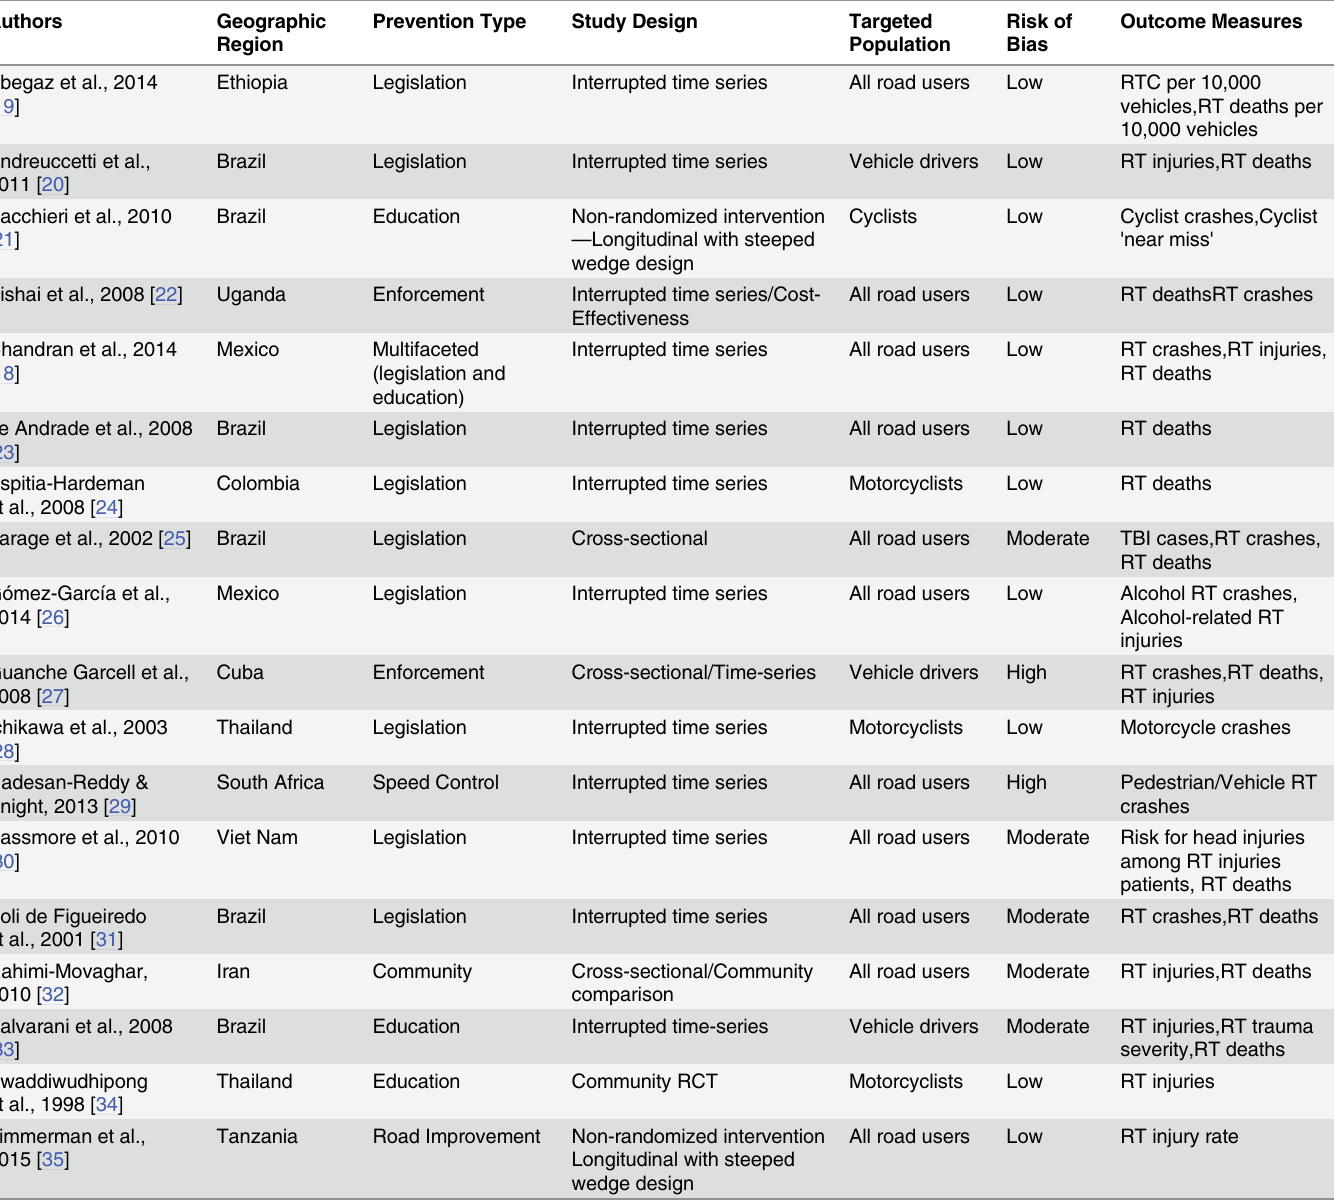
Table 1. Road Traffic (RT) Injury Prevention Study